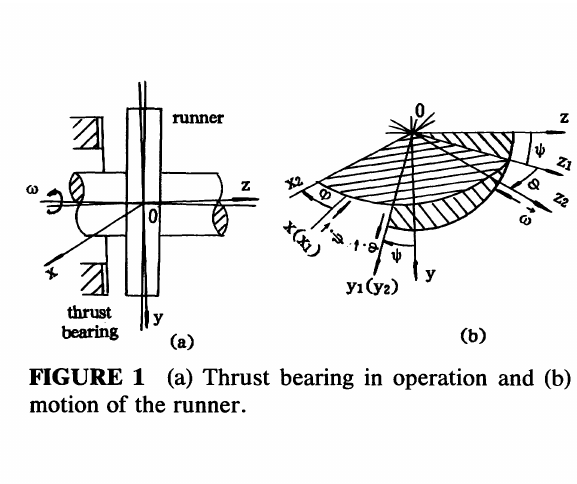
FIGURE 1 (a) Thrust bearing in operation and (b) motion of the